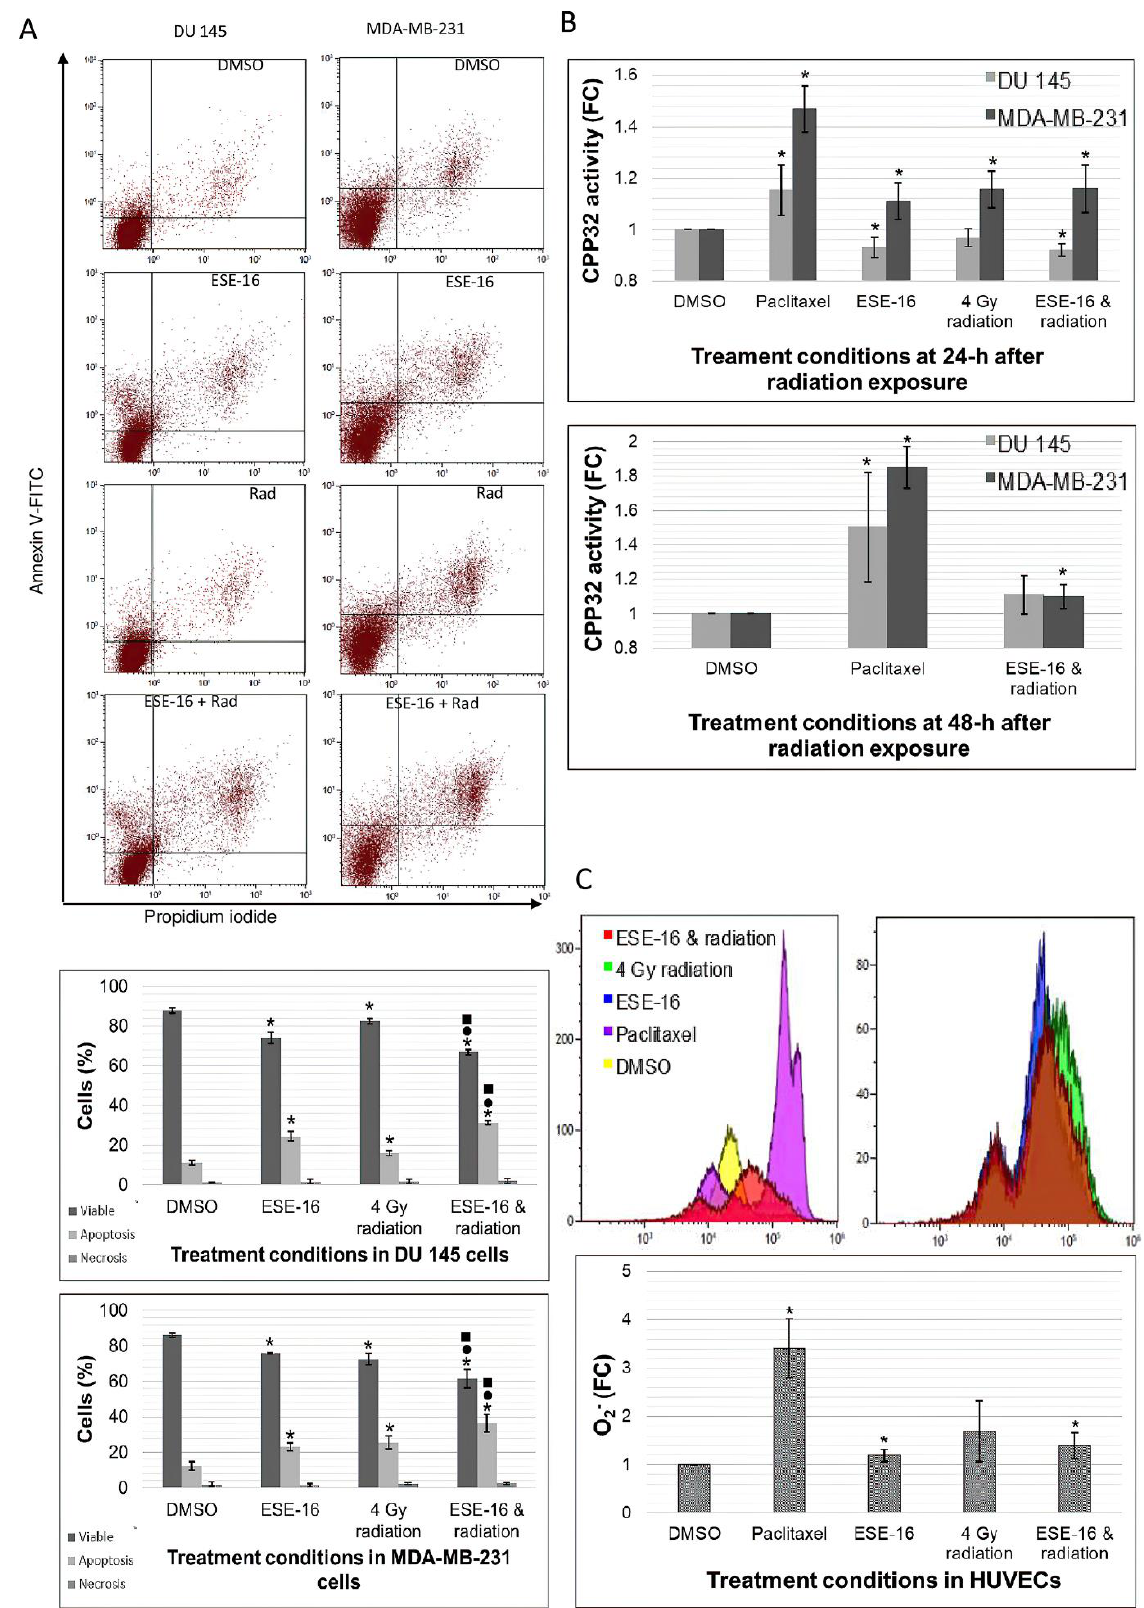
Figure 4. Annexin V-FITC apoptosis detection, caspase 3 activity, and O 2 − detection. ( A ) Flow cytometric dot plots with Annexin V-FITC (FL1) plotted against PI (FL3) of DU 145 and MDA-MB-231 cells exposed to ESE-16 and 4 Gy radiation. DMSO was used as the vehicle control. Apoptotic effects were observed in the ESE-16/4 Gy radiation combination treatment when compared to the treatments individually. ( B ) Graphical representation of CPP32 activity in DU 145 and